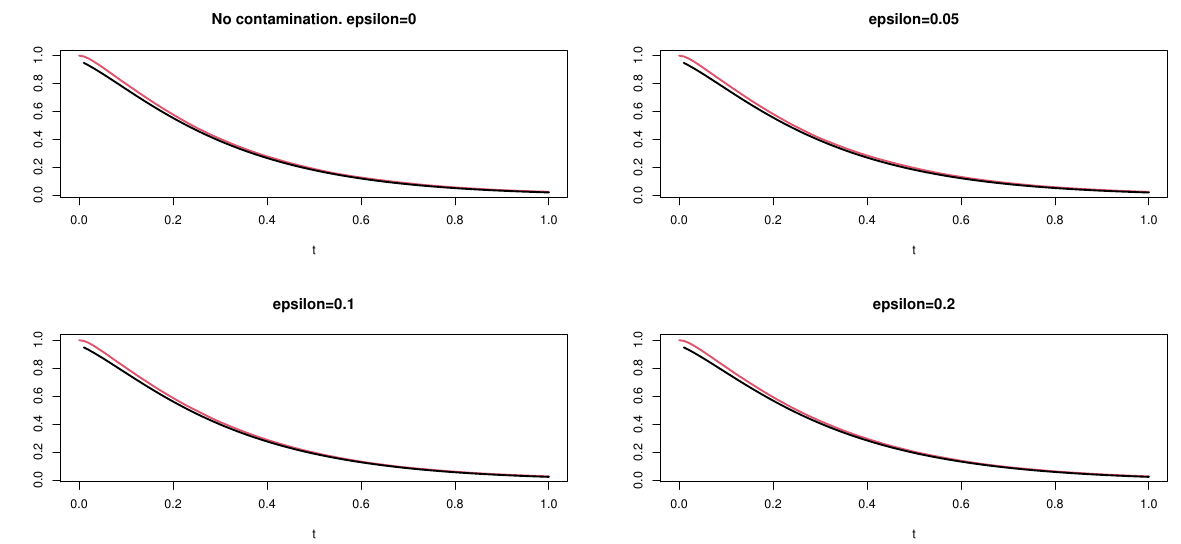
Figure 1. Approximate tail probabilities (in black) and simulated (in red) for the method-of-moments estimator 2 (cid:99) γ ij ( h ) with sample size N h = 3, with no contamination, and with three different degrees of contamination (cid:101)